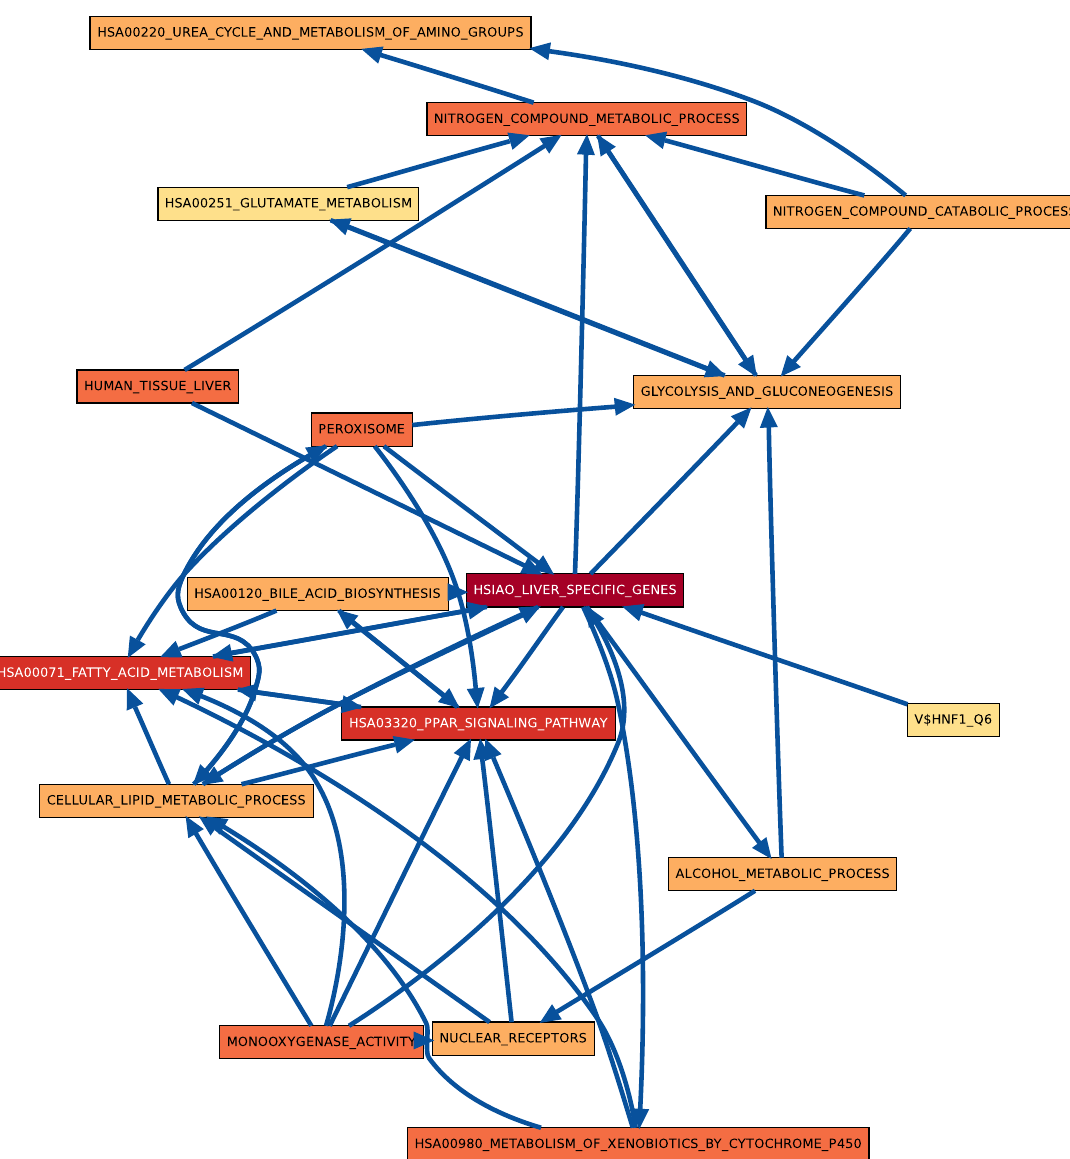
Figure 3. CS vs. HM CBPLN on day 3.